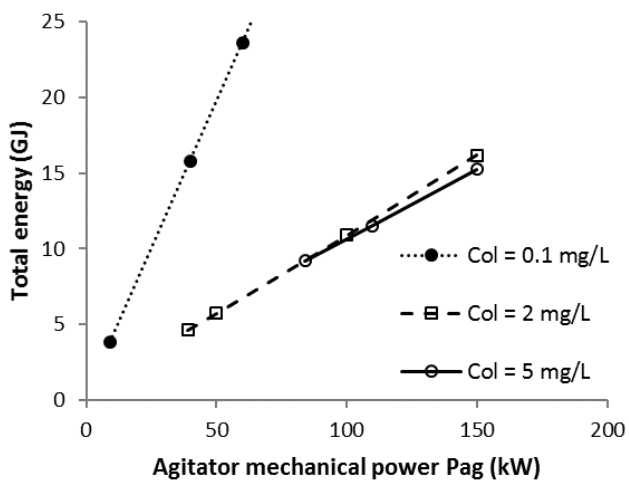
Figure 6. Scenario C1: Influence of constant values of Pag and oxygen concentration in the bioprocess liquid ( C OL ) on total electric energy requirement. ChemEngineering 2018 , 2 , x FOR PEER REVIEW 12 of 22